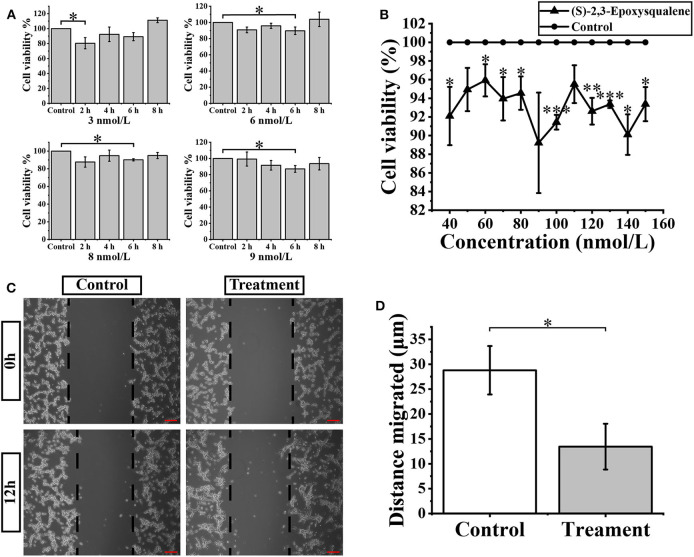
Cellular activity and migration analysis. (A) U87-MG cells were treated with the 3-9 nmol/L (S)-2,3-Epoxysqualene for 2–8 h, and cell viability was measured by the CCK8 assay. (B) CCK8 assay measures cell viability after treatment of 100 nmol/L (S)-2,3-Epoxysqualene of U87-MG cells for 12 h. (C) Effects of 100 nmol/L (S)-2,3-Epoxysqualene on U87 cell migration. The scale bar = 50 μm. (D) The migration distance of U87cells after 100 nmol/L (S)-2,3-Epoxysqualene treatment quantified by Image J software. Data represent means ± SD (n = 3). *P < 0.05, **P < 0.01, ***P < 0.001 by Student's t test.